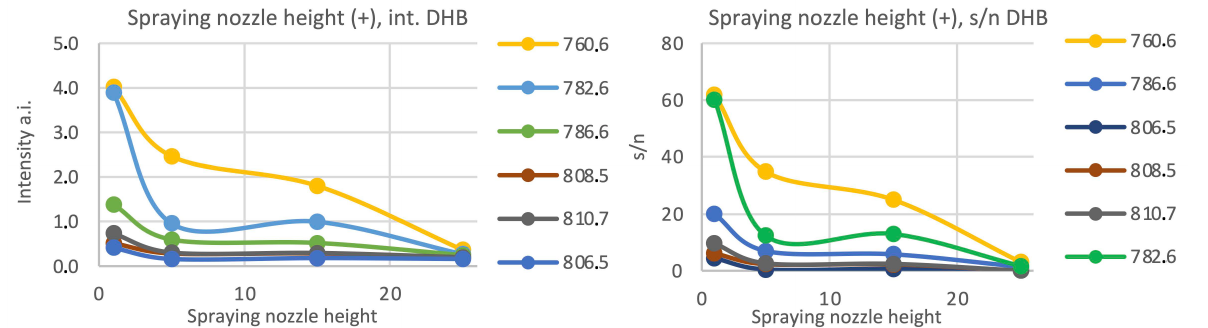
Figure 3. The relationship between the chosen peaks’ intensities and signal-to-noise ratio (s/n) in terms of the spraying nozzle height for the positive ionization mode, matrix: 25 mg/mL DHB (50% MeOH, 0.2% TFA), number of matrix layers: ten (L =